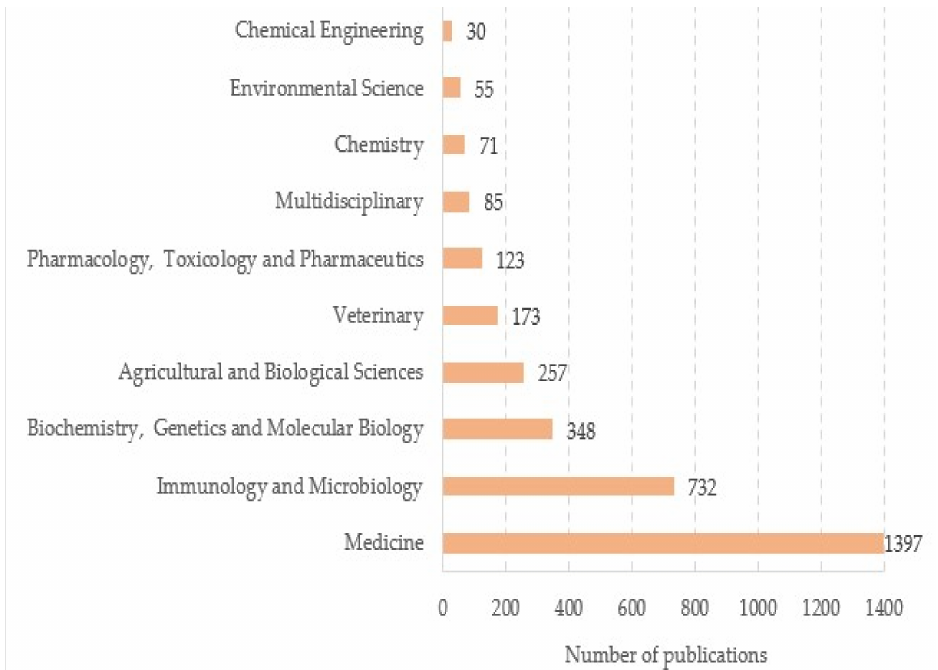
Figure 5. The top 10 research